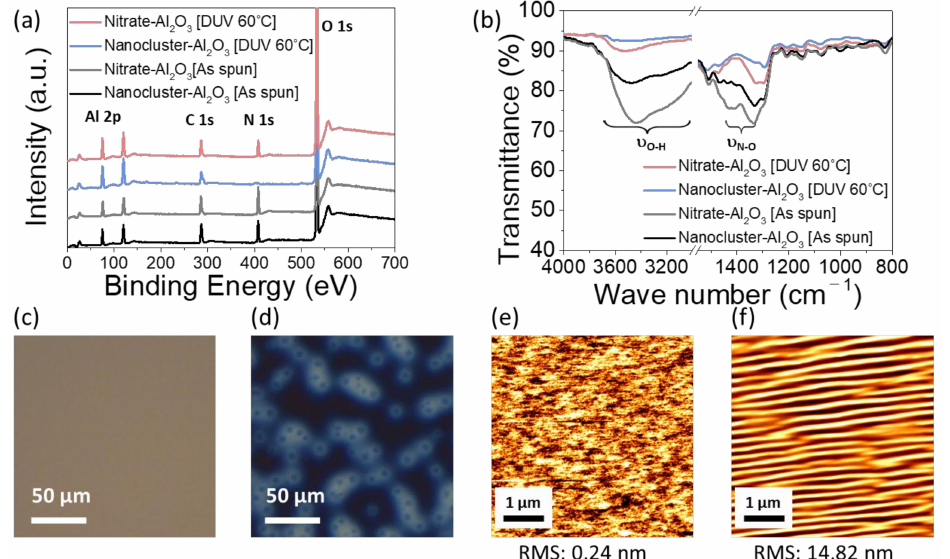
Figure 2. ( a ) XPS survey scan and ( b ) FT-IR spectra showing the compositional change of nanocluster- and nitrated-based Al 2 O 3 film with deep ultraviolet (DUV) annealing at 60 ◦ C. Optical microscope (OM) images of ( c ) nanocluster-based Al 2 O 3 film and ( d ) nitrate-based Al 2 O 3 film. Atomic force microscopy (AFM) noncontact-mode topography of ( e ) nanocluster-based Al 2 O 3 and ( f ) nitrate-based Al 2 O 3